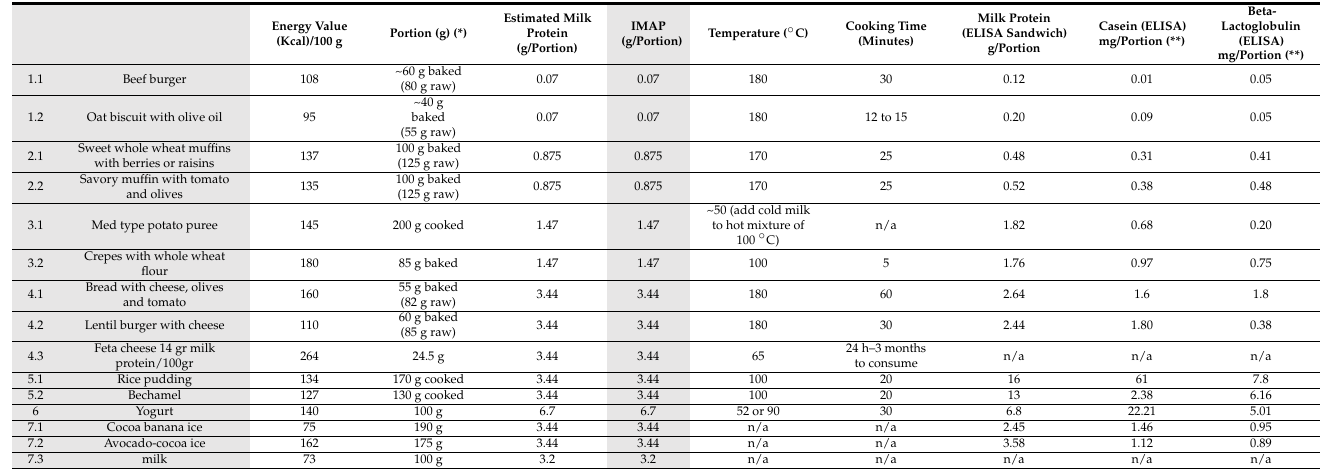
Table 2. Amounts of milk and cooking temperatures in the Mediterranean milk ladder recipes in comparison to the IMAP milk